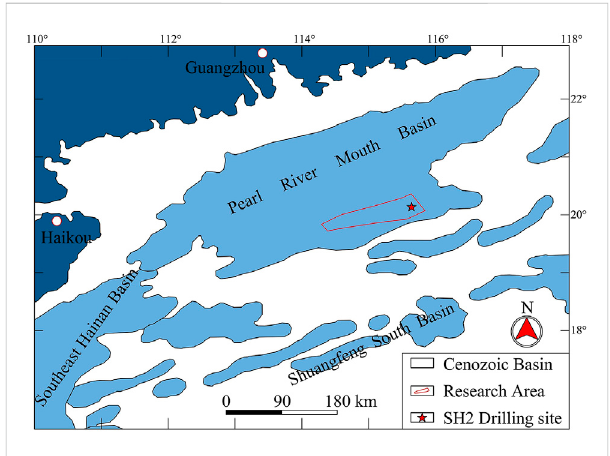
FIGURE 2 Location map of the GMGS-1 project in the Shenhu Area of the South China Sea (adapted from Wu et al.,